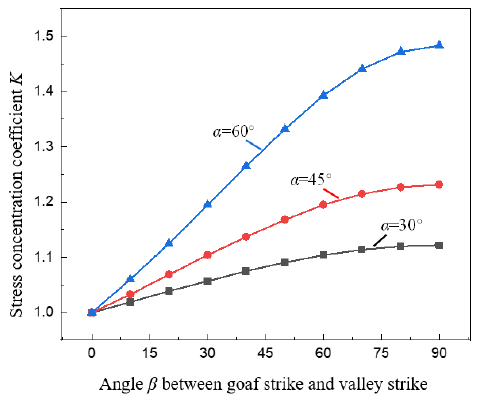
Figure 11. Relationship between goaf strike and stress concentration coefficient K .